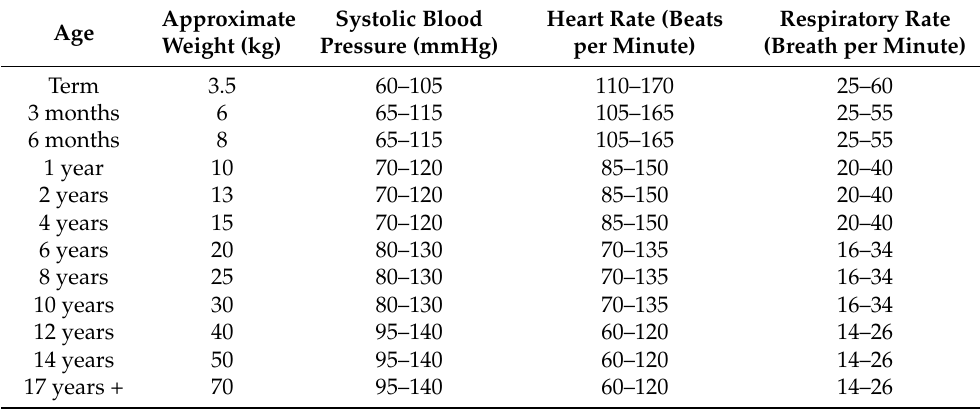
Table 1. Ranges of blood pressure, pulse, and respiratory rate in relation to age of child [7].